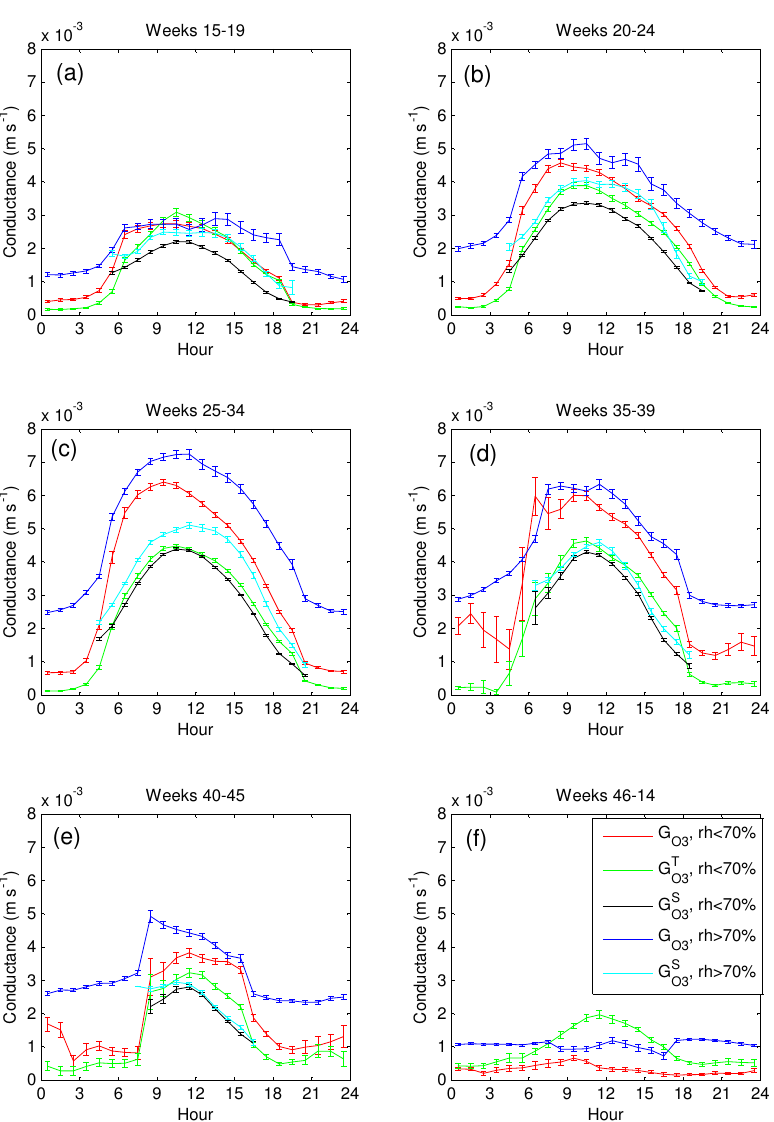
Fig. 3. Diurnal variation of conductances during different seasons (a) weeks 15–19, (b) weeks 20–24, (c) weeks 25–34, (d) weeks 35–39, (e) weeks 40–45, (f) weeks 46–52 and 1–14 for low and high RH conditions. G O and G T ozone stomatal conductance as inferred from water (transpiration) conductance. Values are hourly averages from data for all years O 3 during the given period, bars denote standard